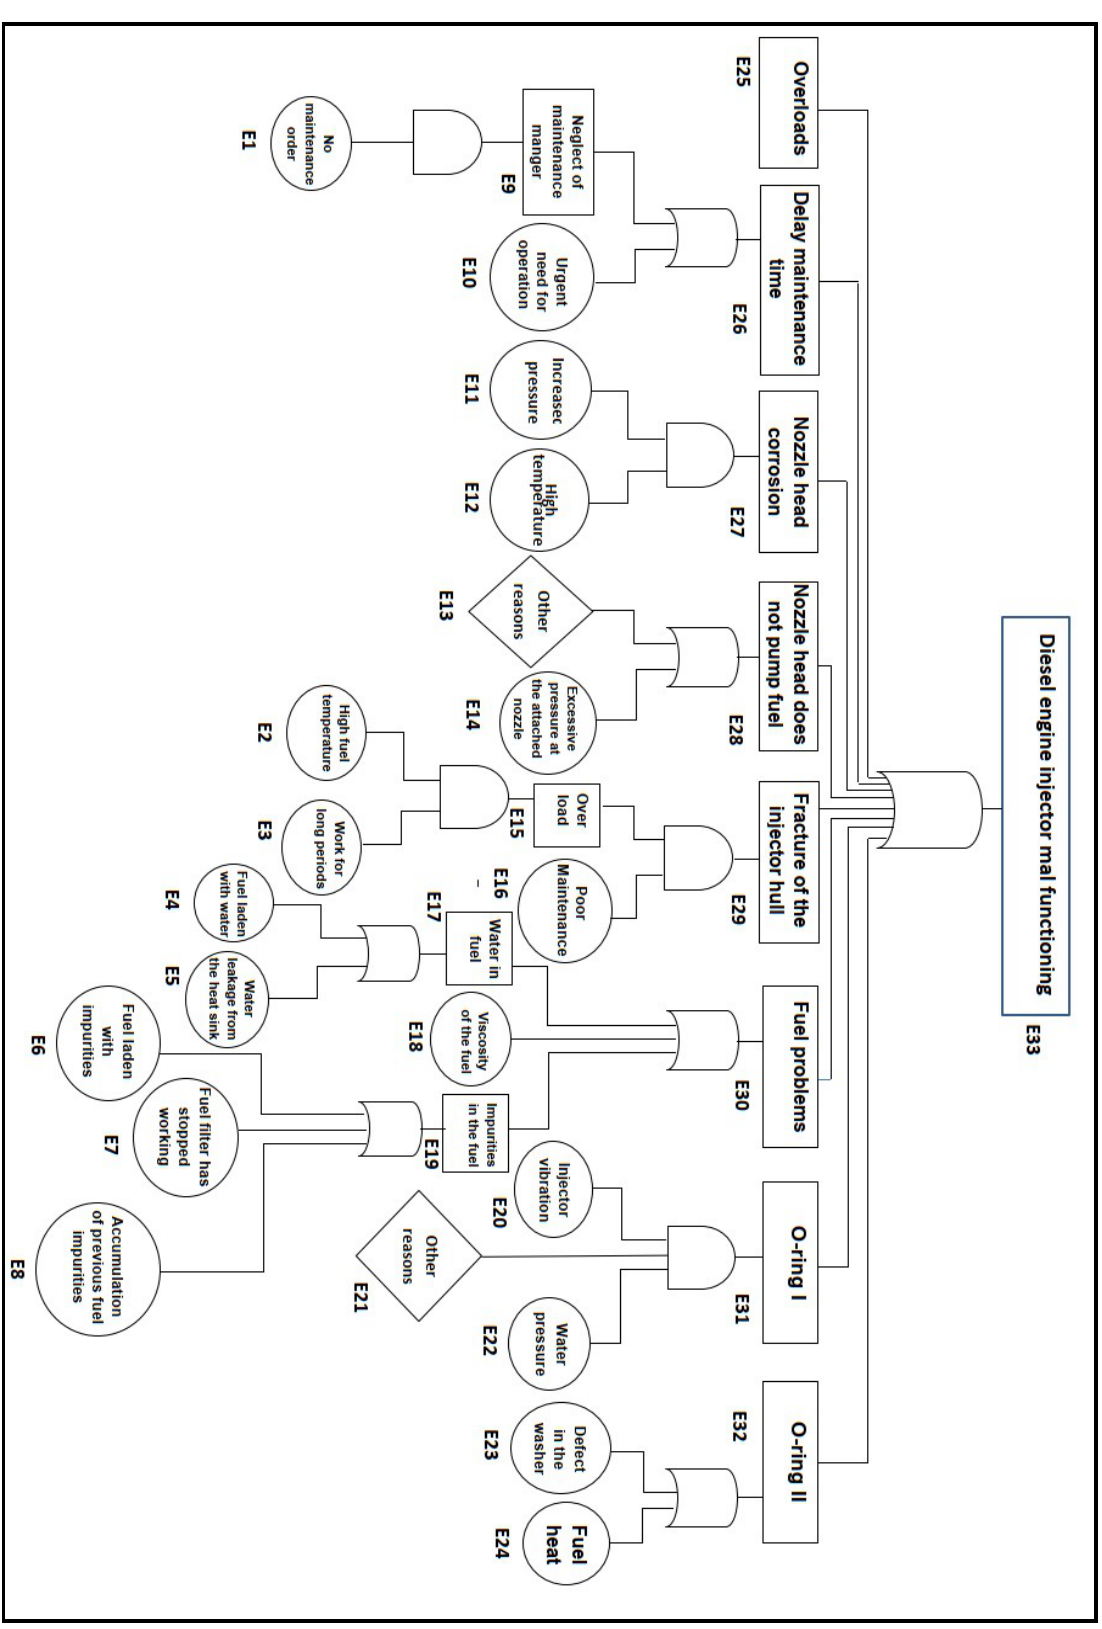
Fig.4. Fault tree analysis of diesel engine